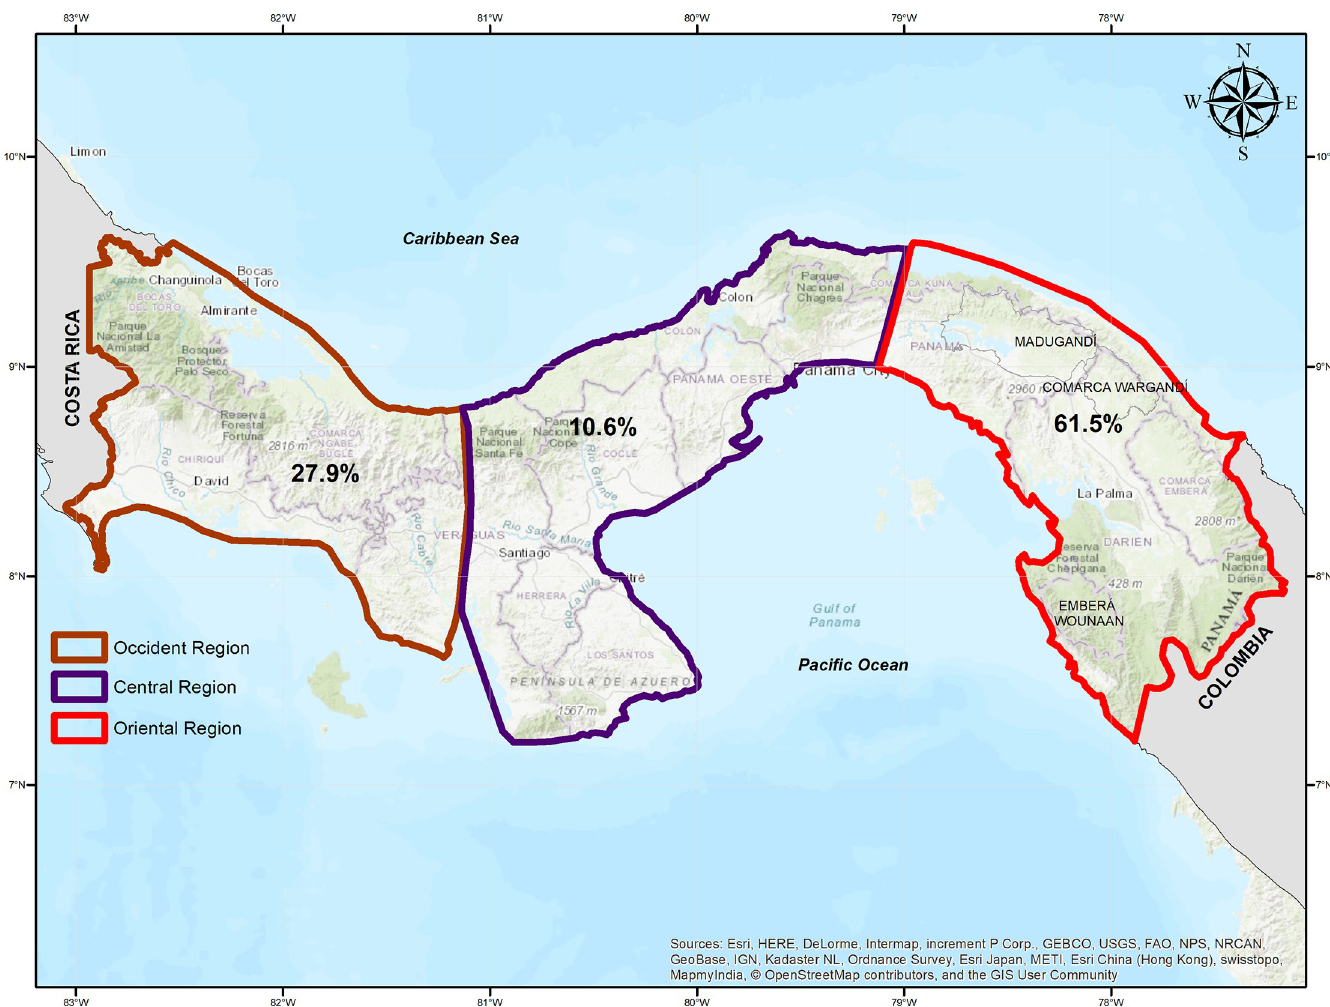
Fig 2. Distribution map of the total malaria cases (as a percentage and by geographic region) in Panama from 2006 to